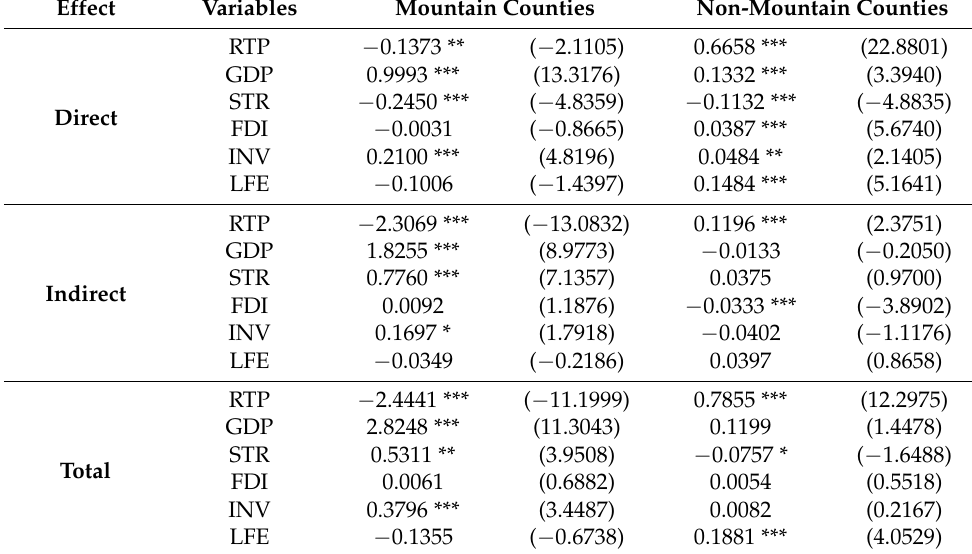
Table 11. Comparison of regression results in mountainous and non-mountainous